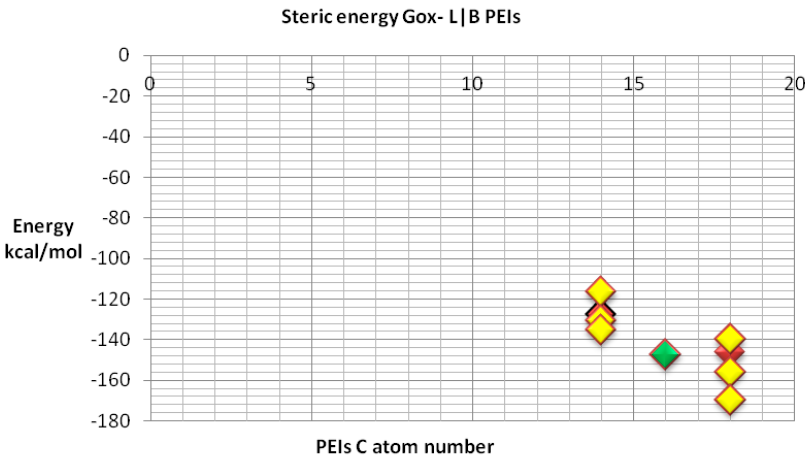
Figure 11. Steric energy for GOx-L/B PEI; the energy of BPEIs (C14 and C18 groups) is represented in yellow; the energy of LPEI C14 and C18 is shown in red; the energy of LPEI C16 is represented in green.